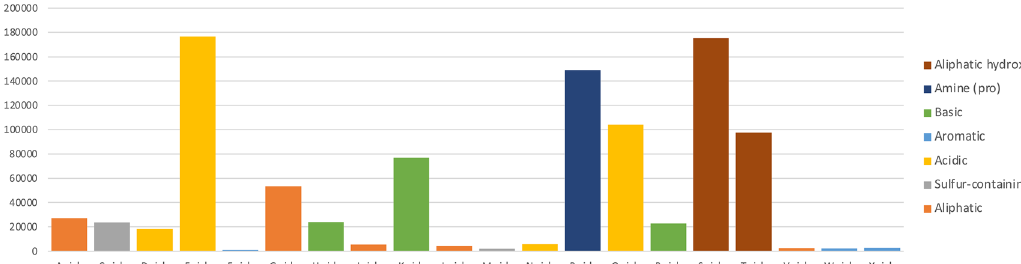
acid frequency in the human genome (i.e. total score/frequency). Higher CAST scores reflect strong compositional biasfor the specific region. The column colourcorresponds to anamino acid classification according to the chemical nature of their side chains (Katchalski-Katzir et al. ,